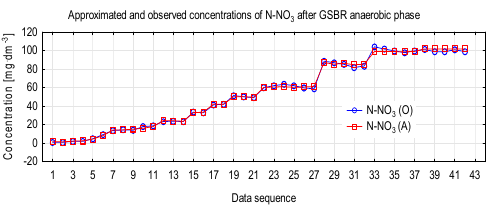
Figure 1. Approximated and observed concentrations of N-NO 3 after sequence bath reactor with aerobic granular activated sludge (GSBR) anaerobic phase.